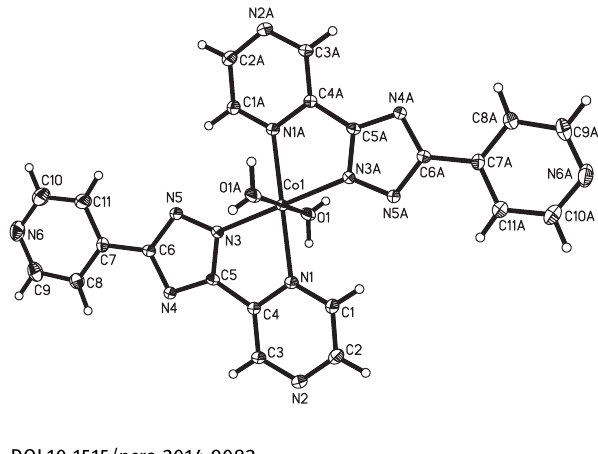
Table 1: Data collection and handling.